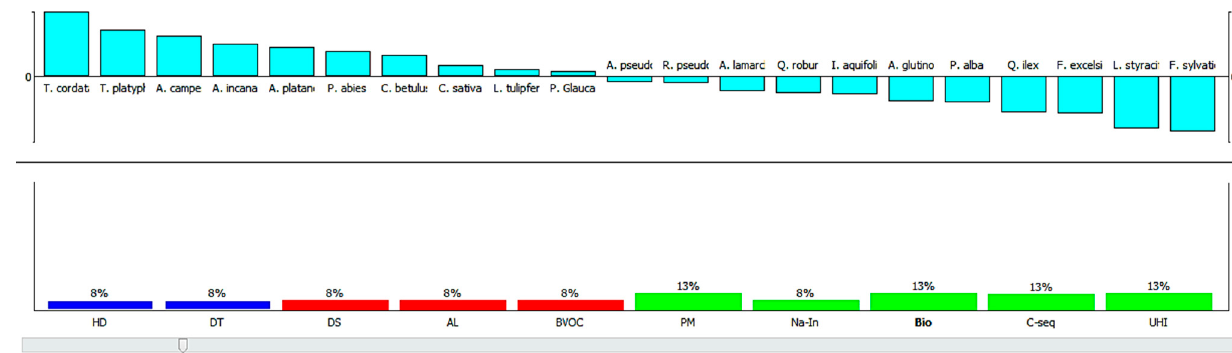
Figure 3 . Ranking of plant species shown in the upper part of the bar chart according to scenario (S2) PM mitigation and environmental adaptability. The lower part of the bar chart shows an equally high importance for hardiness, drought tolerance (dark blue bars), disease susceptibility (red bar), PM mitigation, and native-invasive (green bars). The criteria including allergenicity, BVOC emis- sions (red bars), supporting biodiversity, net carbon sequestration, and reducing urban heat island effect (green bars) are adjusted as having low importance. Plant species are ordered from best to worst. (For an interpretation of the references to color in this figure legend, the reader is referred to the web version of this article.)